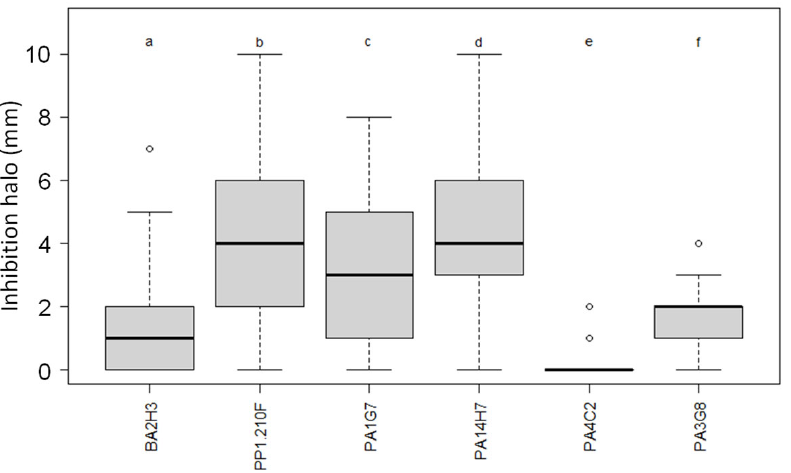
Figure 3. Growth inhibition assays of all six biocontrol agents. Growth inhibition assays were performed against 41 pathogen isolates in triplicate in the presence of each of the biocontrol agents: B. simplex BA2H3, P. brassicacearum PP1-210F and PA1G7, Pseudomonas sp. PA14H7, P. fluorescens PA3G8 and P. lactis PA4C2. In this graph, we calculated and showed mean value and variation of 123 halo values (41 pathogen isolates in triplicate) for each biocontrol agent. Statistical differences (Kruskal–Wallis test multiple comparison (Dunn), p -value adjusted with the Benjamini–Hochberg method, alpha = 0.05) are indicated by different letters (a to f); horizontal bar indicates mean value.